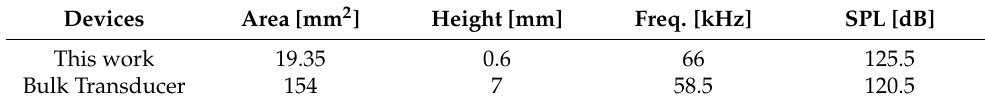
Table 2. Comparison of our device and bulk transducer.